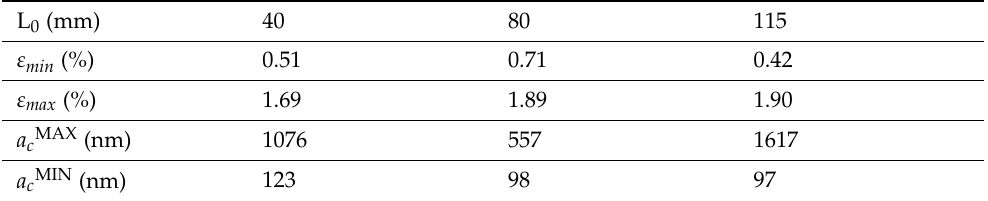
Table 3. Values of extreme strain extracted from the empirical z p ( ε p ) diagrams and related critical flaw sizes.